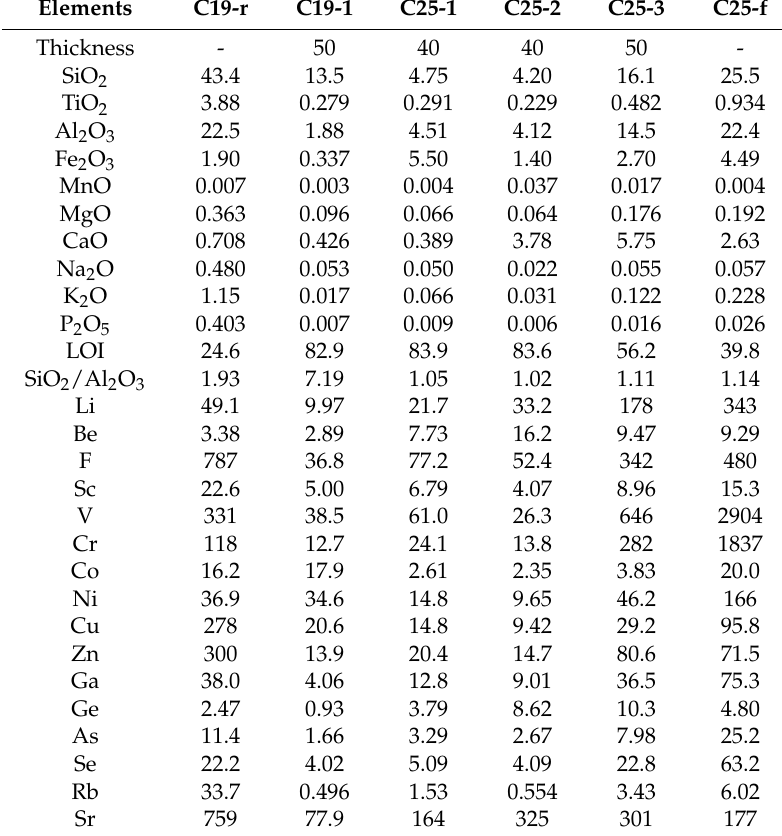
( μ g/g) in the Shiping coals and host rocks.